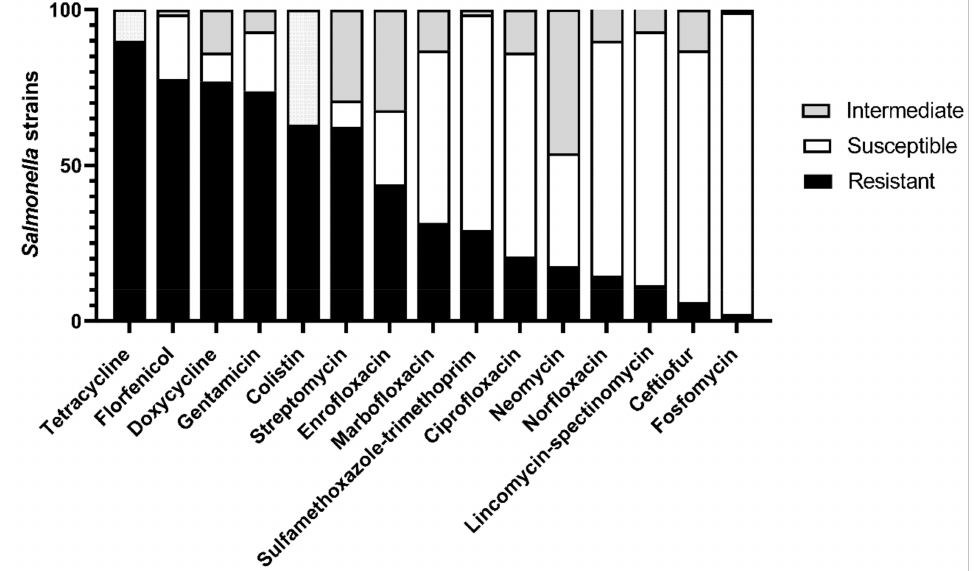
Figure 2. Percentage of in vitro antimicrobial resistance of 130 Salmonella strains from pig salmonel- losis against 14 antimicrobials by disk diffusion method. Resistance to colistin was determined by minimal inhibitory concentration (MIC) using a broth microdilution method. Results for both methods were interpreted according to EUCAST version